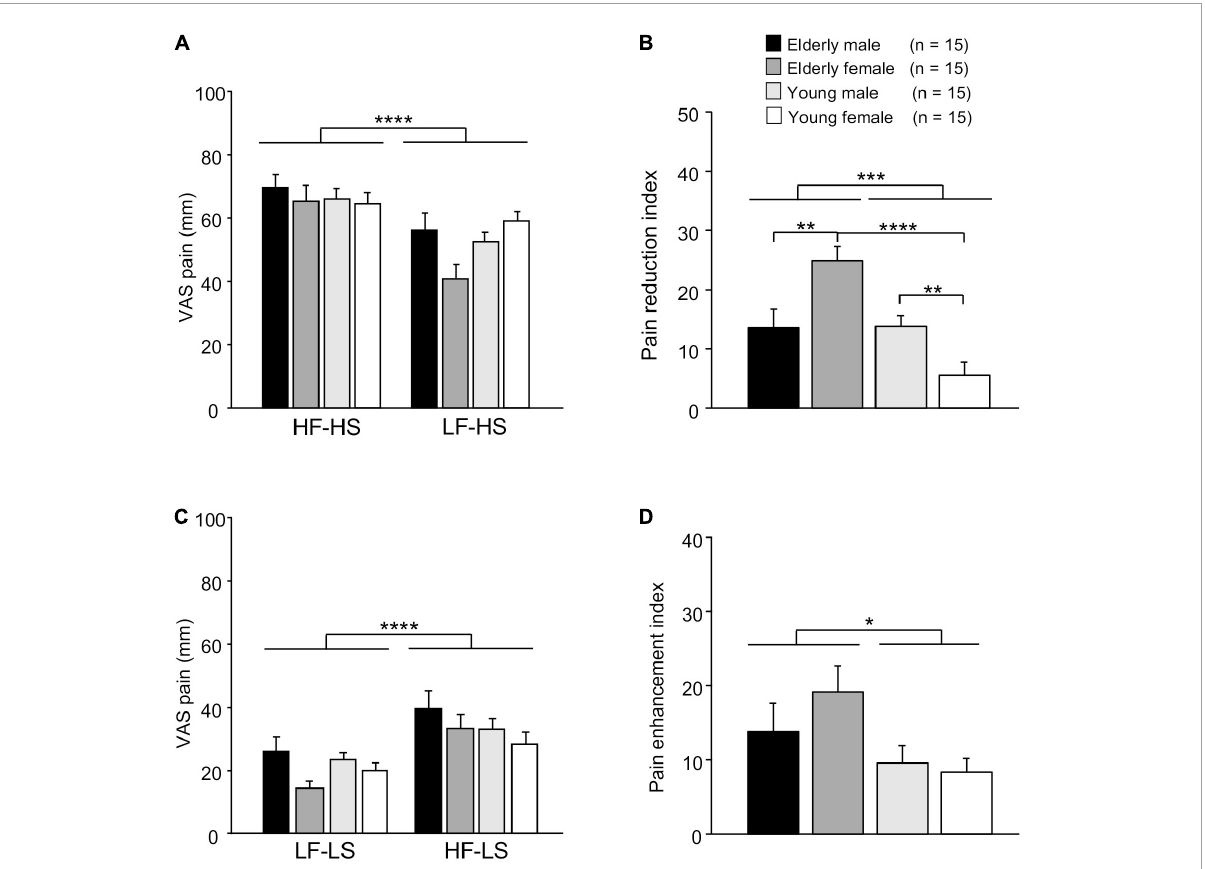
FIGURE2 Comparison of VAS scores of electrical shocks among groups. (A) Comparison of VAS scores of high-intensity electrical shock (HS) following the two different sounds. VAS, visual analog scale; HF-HS, HS following the high frequency (HF) sound; LF-HS, HS following the low frequency (LF) sound. (B) Comparison of pain reduction indices (difference in VAS pain scores of HS = VAS in HF-HS – VAS in LF-HS). (C) Comparison of VAS scores of low-intensity electrical shock (LS) following the two different sounds. LF-LS, LS following the LF sound; HF-LS, LS following the HF sound. (D) Comparison of pain enhancement indices (difference in VAS pain scores of LS = VAS in HF-LS – VAS in LF-LS). Error bars indicate the SEM. *, **, ***, ****, p < 0.05, 0.01, 0.001, 0.0001,